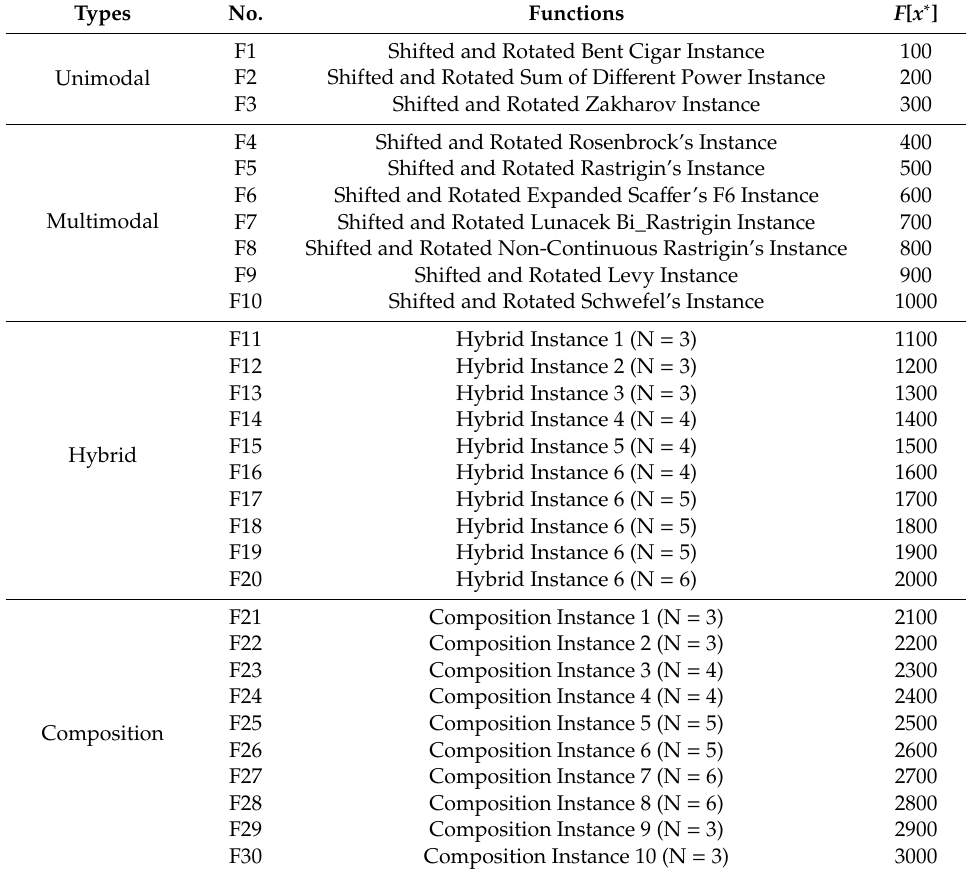
Table A5. CEC2017 benchmark functions with initialization and search range: ( − 100,100) D